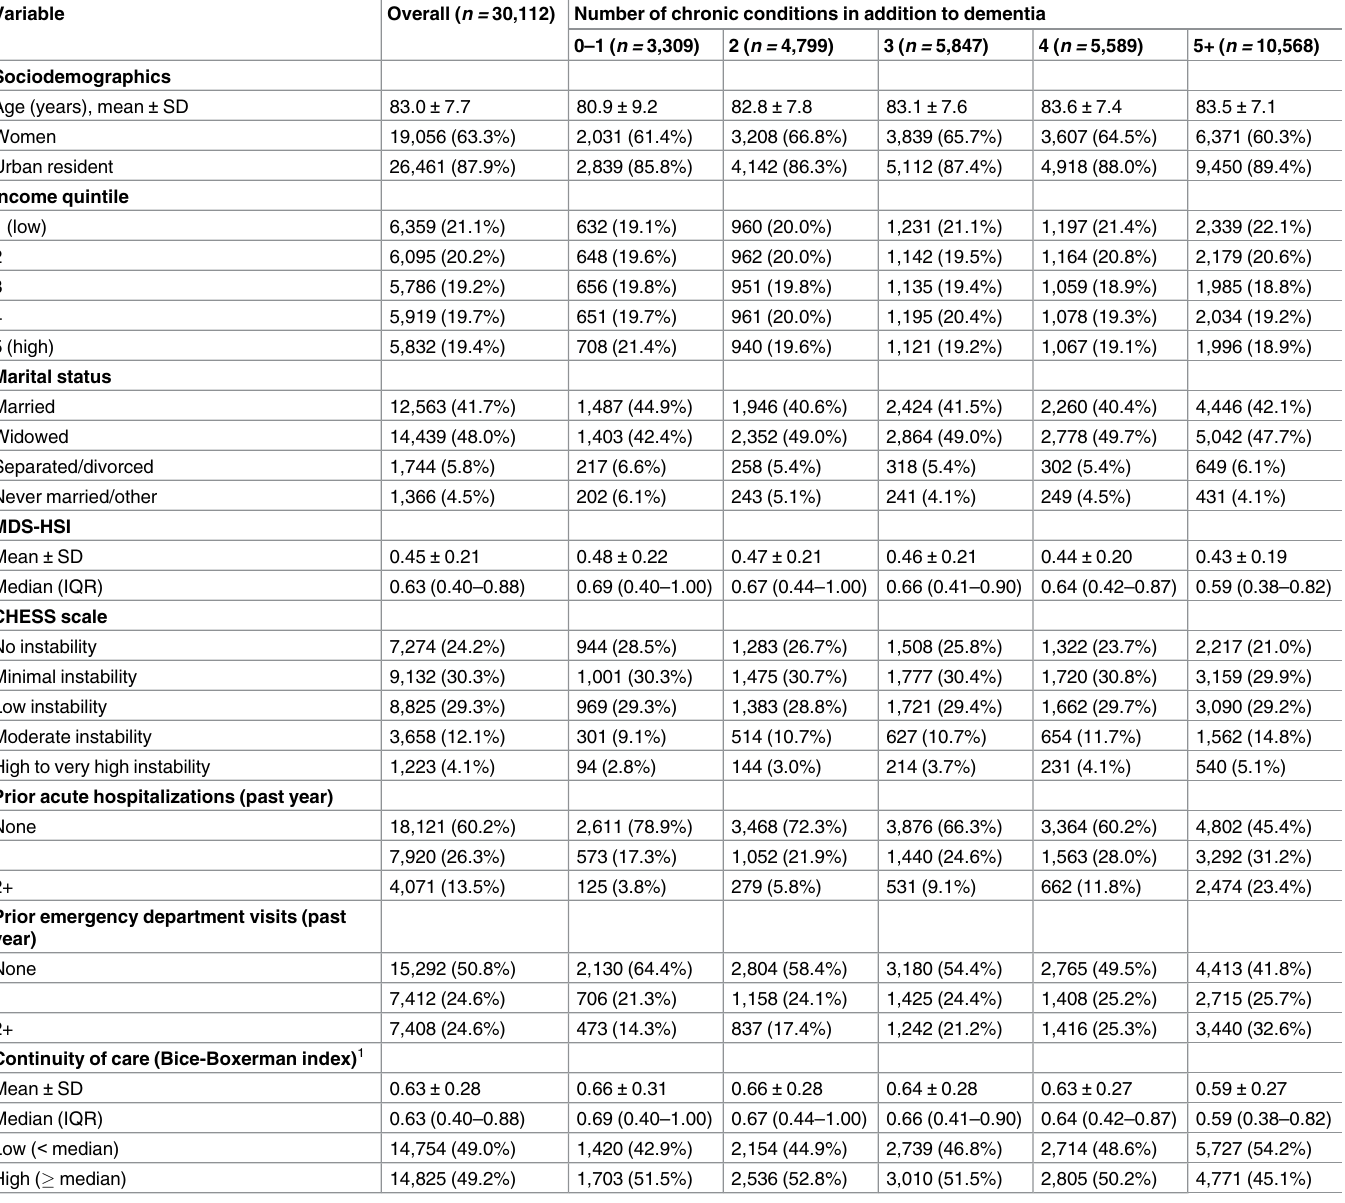
Table 1. Profile of long-stay home careclients with dementia in Ontario in 2012, by level of multimorbidity (number of prevalentchronic conditions in addition to dementia).